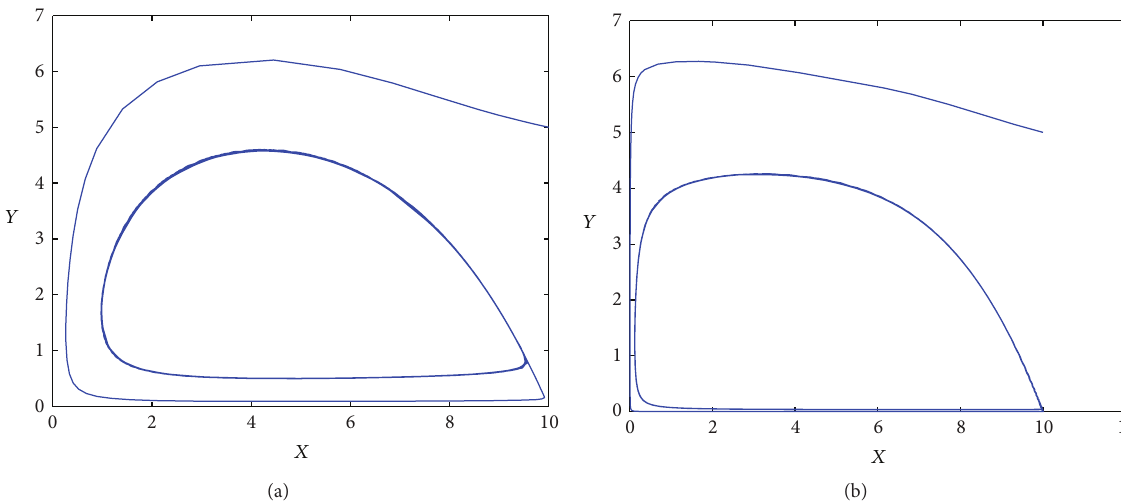
Figure 5: The infected steady state 𝐸 ∗ of system (2) without term 𝑒 −𝑚𝜏 is unstable when 𝜏 = 0.75 (a) and 𝜏 = 10 (b). The rest parameter values are given in (i), and the initial values are 𝑥 0 = 8 and 𝑦 0 = 5 .